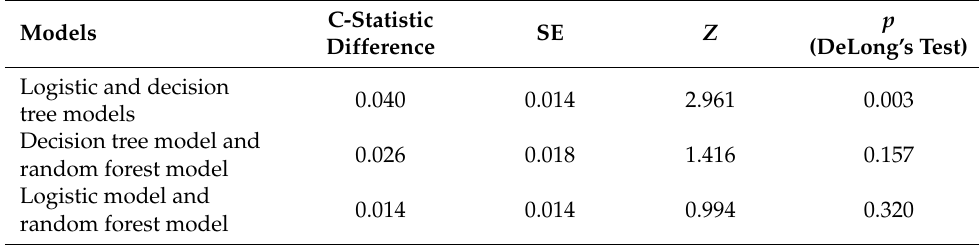
Table 9. Model prediction accuracy